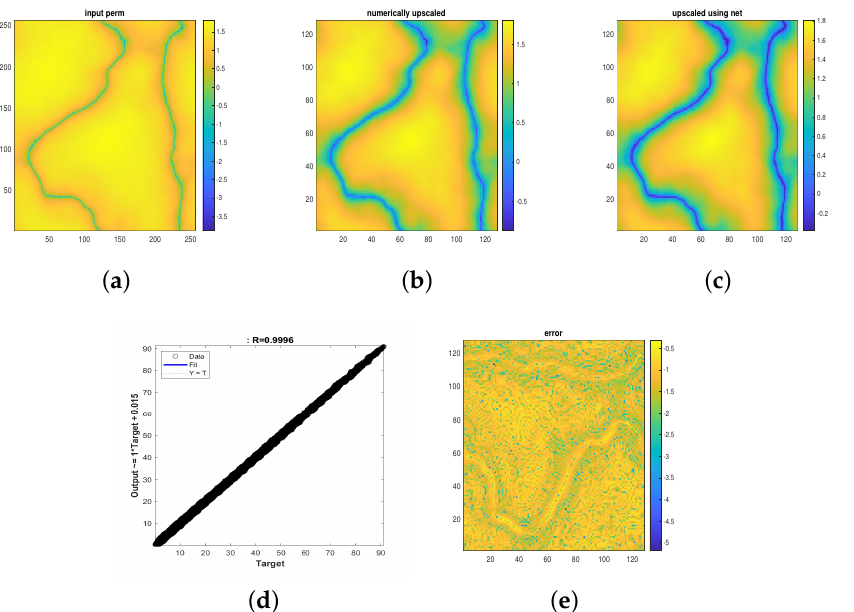
Figure 15. ( a ) Input channel permeability distribution on a 128 × 128 grid size. ( b ) The numerically upscaled permeability field on a grid of 64 × 64 grid cells. ( c ) The neural upscaled permeability field on a grid of 64 × 64 grid cells. ( d ) Figure showing regression fit on training and testing data. ( e ) Figure showing log plot of error between numerically upscaled permeability and neural upscaled permeability.